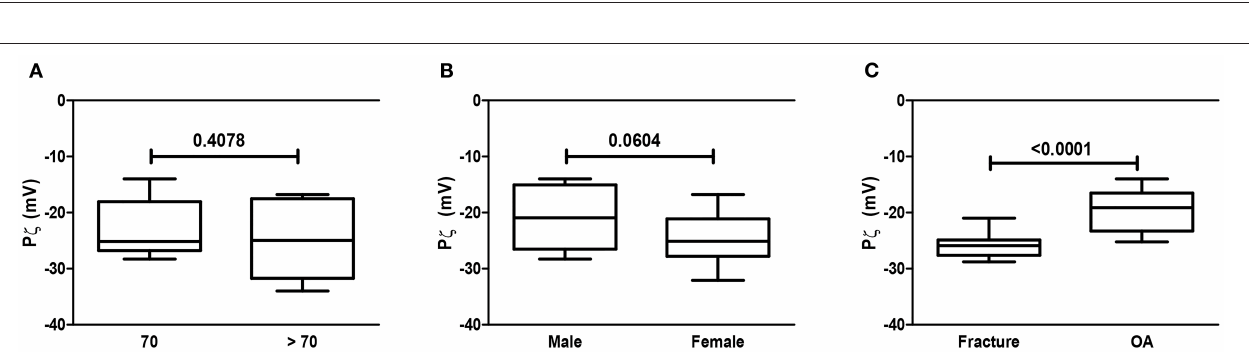
FIGURE 5 | Analysis of the zeta potential (Pz). Analysis of the Pz of GAG from human cartilage samples of patients subjected to arthroplasty secondary to OA or fracture. Data are expressed as mean ± SEM of zeta potential (mV) considering age ( > / ≤ 70 years old) (A) , gender (B) , and (C) OA/fracture of at least n = 6/group; Student t